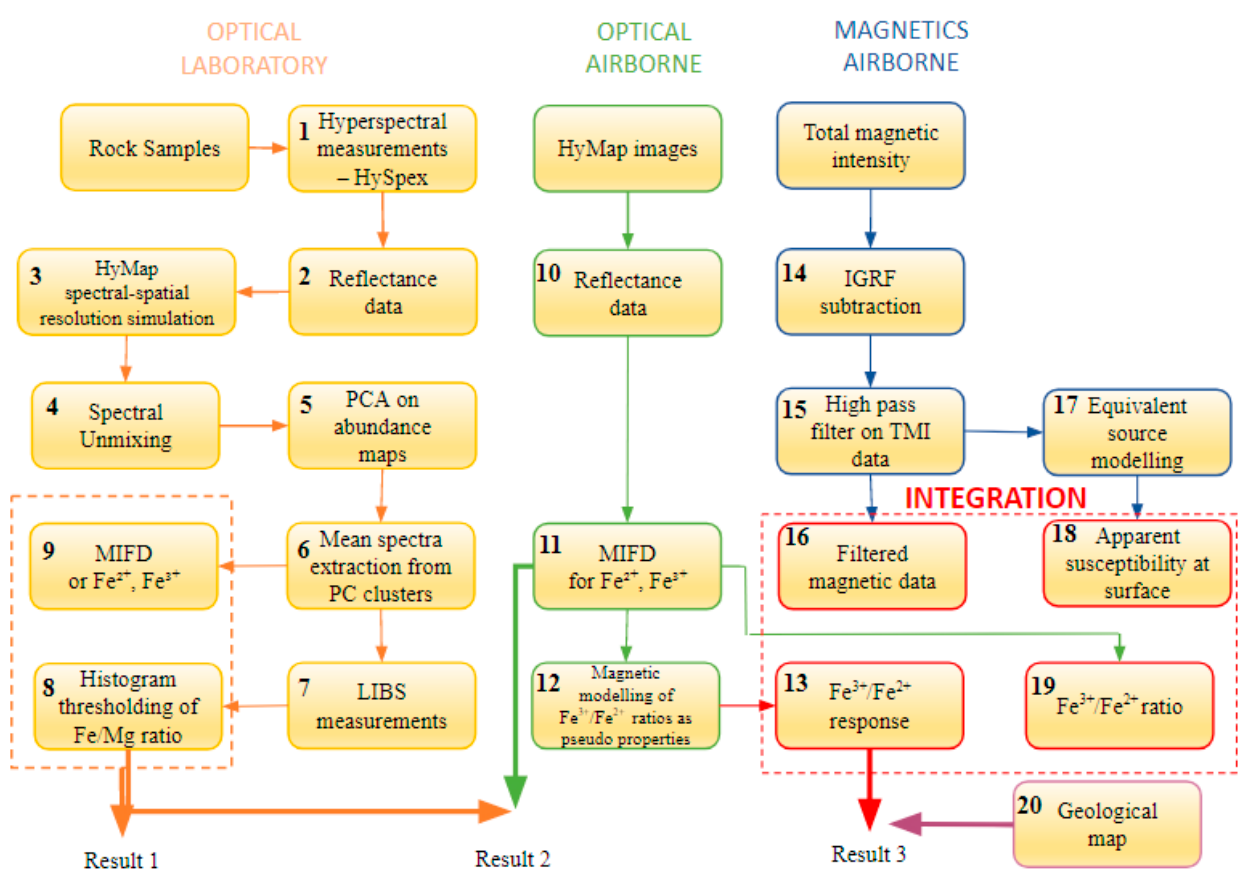
Figure 6. Generalized process chain of the proposed data integration approach.